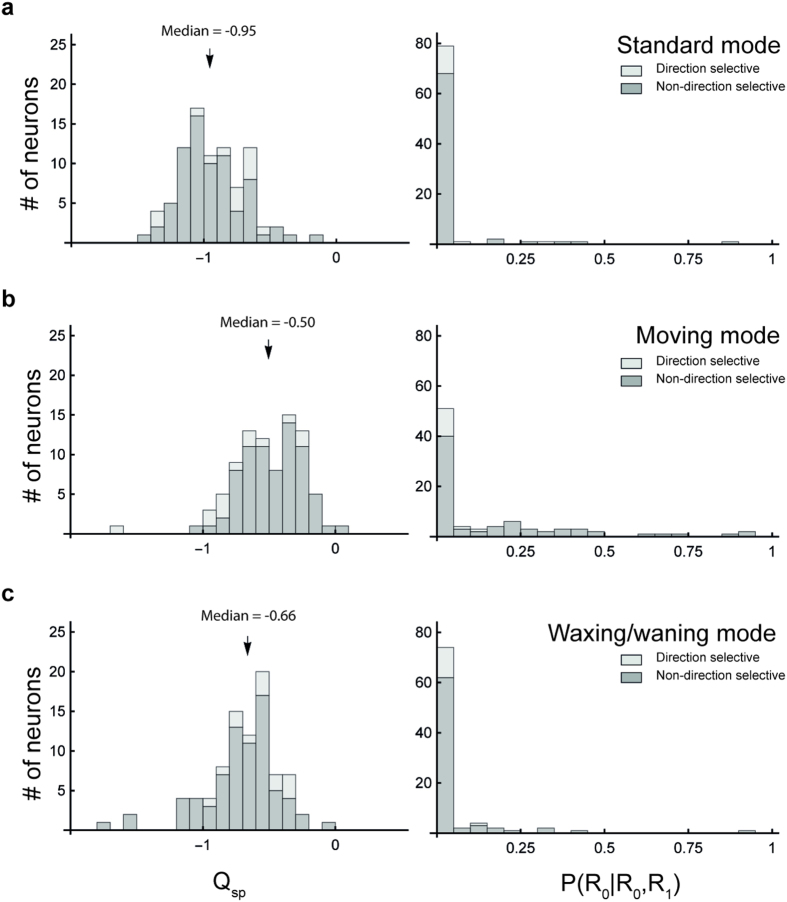
Distributions of Qsp and P(R0|R0, R1) under the stimulation of the 3 modes in V1.The format is the same as in Fig. 6. The bars shaded by the lighter grey level represent neurons that are direction selective, whereas bars shaded by the grey level represent neurons that are not direction selective.